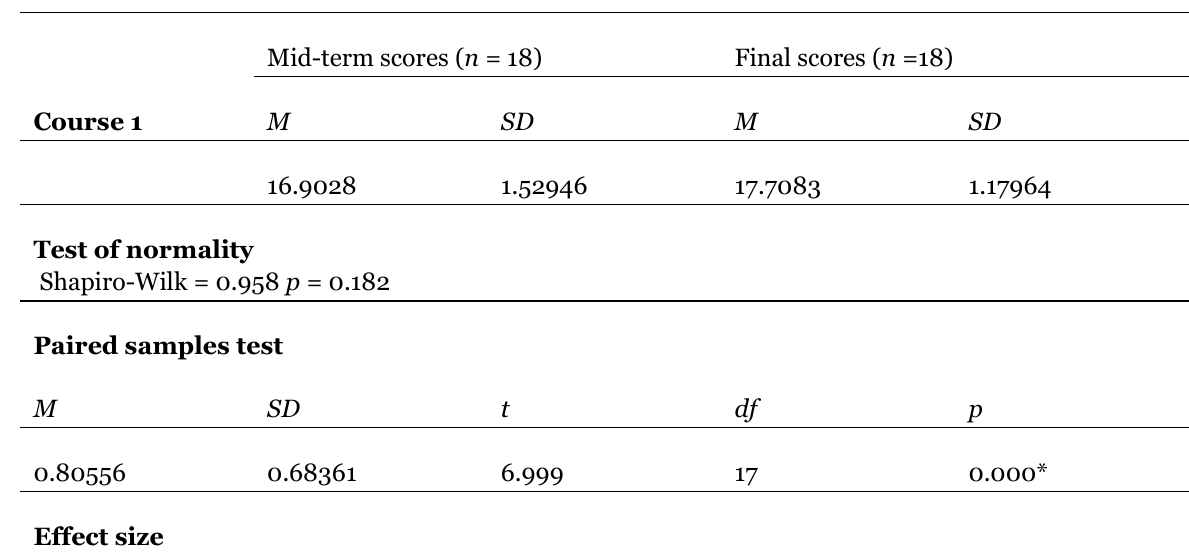
Paired Samples t-Test Results for Preservice Teachers’ Achievements in Online Course 1